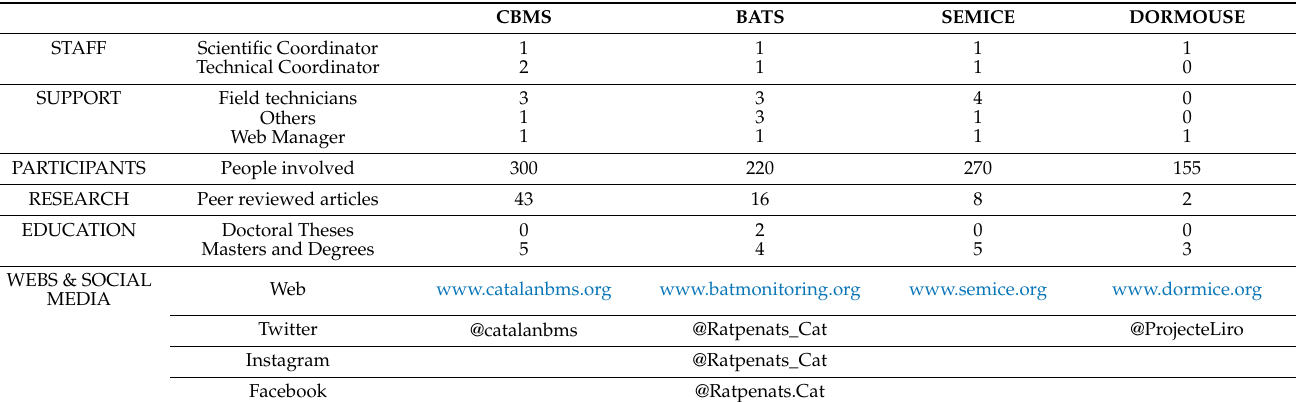
Table 2. General information about the four monitoring